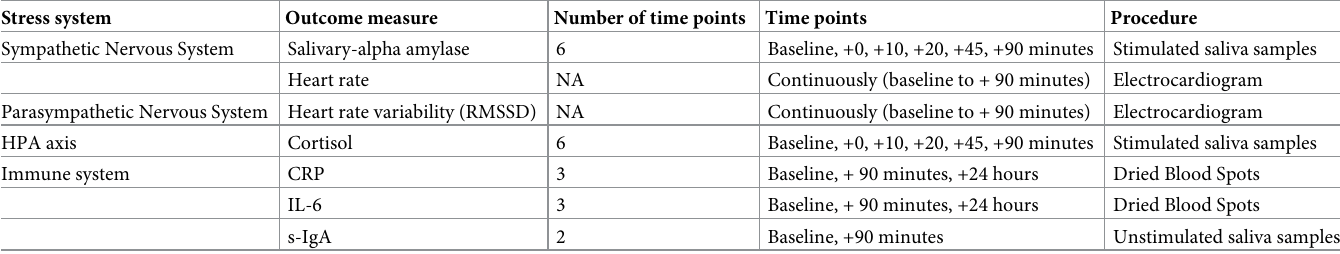
Table 2. Biological and physiological outcome measures, number of samples, collection time point, and assessment